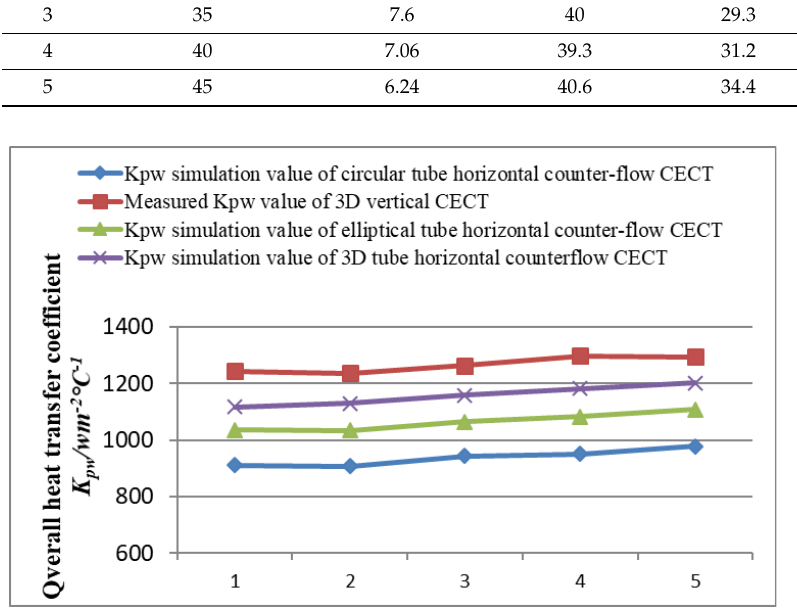
Figure 9. Comparison of the overall heat transfer coefficients K pw for the vertical CECT with the other three horizontal CECTs. As can be seen from Figure 9, the variation trend of the tested K pw value for the verti- cal CECT is basically consistent with the K pw calculated value for the other three horizontal CECTs. The overall heat transfer coefficients for the vertical CECT are 35.06%, 18.97%, and 9.45% higher than that for the other three horizontal-arrangement CECT, respectively. This is mainly because the convection heat transfer performance of the fluid inside and outside the irregularly shaped tube is improved compared with that of the circular tube. Moreover, the fluid disturbance of the 3D deformation tube is more obvious, so the per- formance improvement is the most significant. The overall heat transfer coefficients of the vertical 3D deformation-tube CECT is higher than that of the horizontal 3D deformation- tube CECT. The main reason is that after changing the tube bundle from the horizontal to the vertical arrangement, the wrapping condition of the water film outside the tube is further improved. The heat transfer coefficient of the water-film side outside the tube is increased, leading to a significant improvement in the overall heat transfer coefficients. The measured results only show the comparison of the overall heat transfer coefficient between the vertical arrangement and the horizontal arrangement of the CECT under the